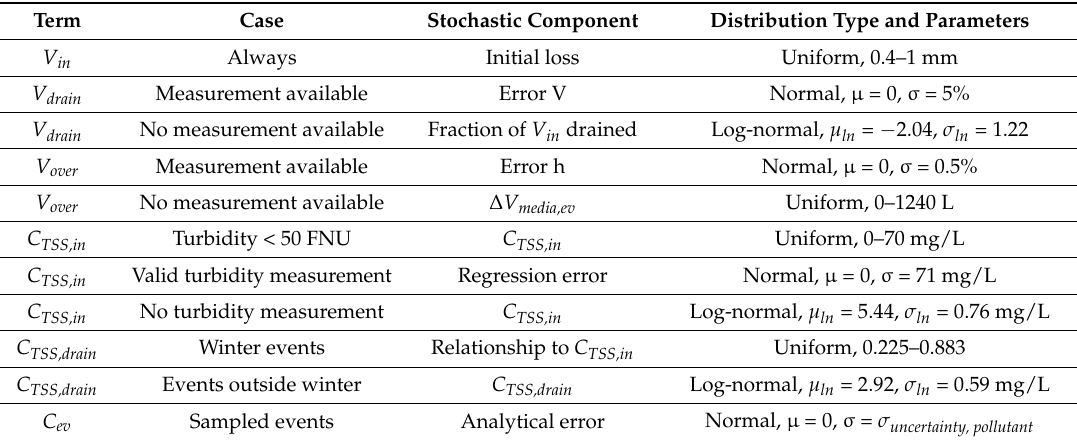
Table A2. Summary of distributions used for calculating event volumes (V), TSS concentrations ( C TSS ) and sampled event mean concentrations ( C ev ) used in load calculations.